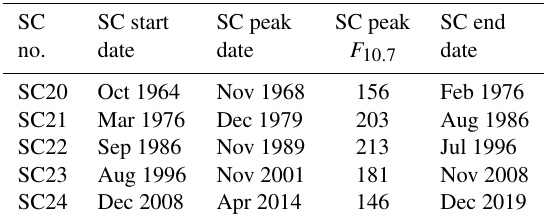
Table 2. Details of the solar cycles under present